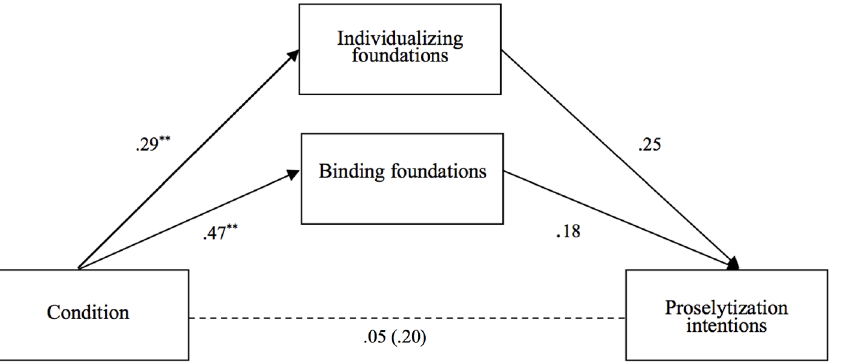
Figure 2. Indirect effect of Condition (moral vs practical) on proselytization intentions via both indices of moral expressiveness. * p < .05. ** p <